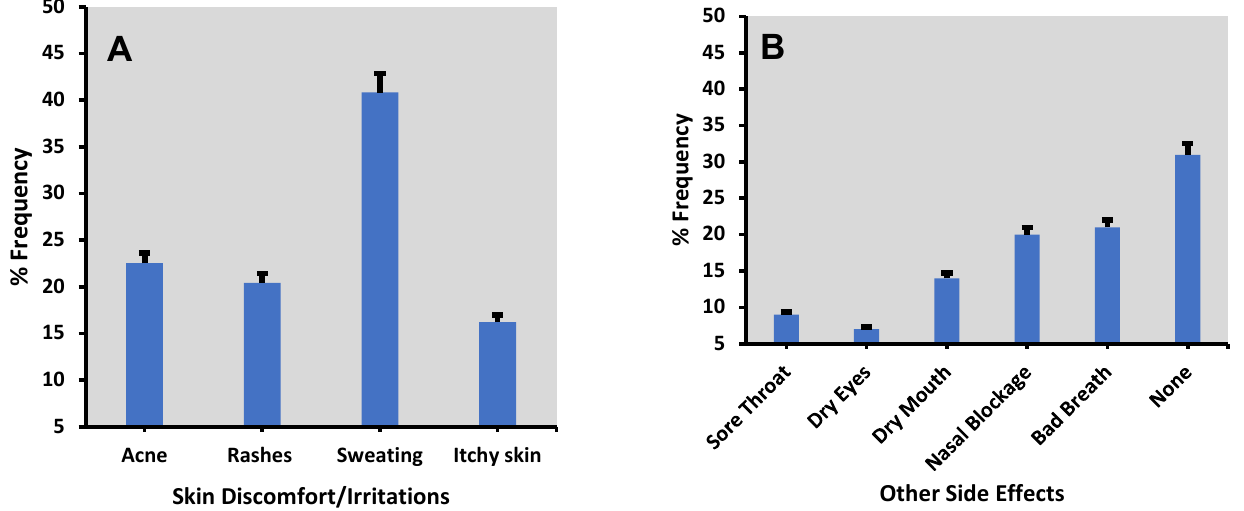
Figure 2. Side effects of nose mask usage as indicated by the respondents. Error bars represent the percentage of reported side effects.